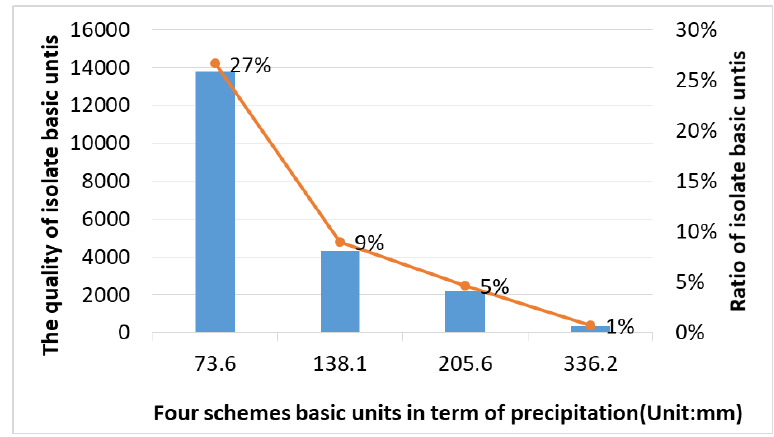
Figure 5. The amount of isolated basic units distributed in the four precipitation schemes.